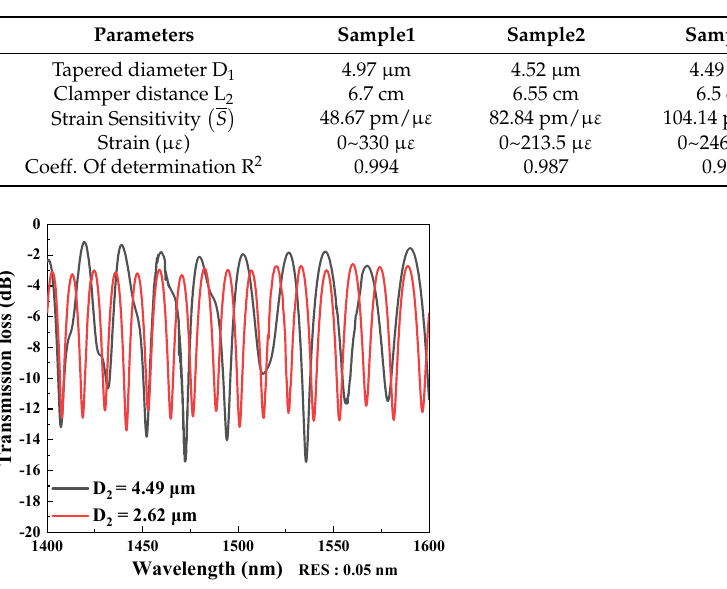
Figure 2. Spectral responses of the interferometers with D 2 = 2.62 μm and 4.49 μm.